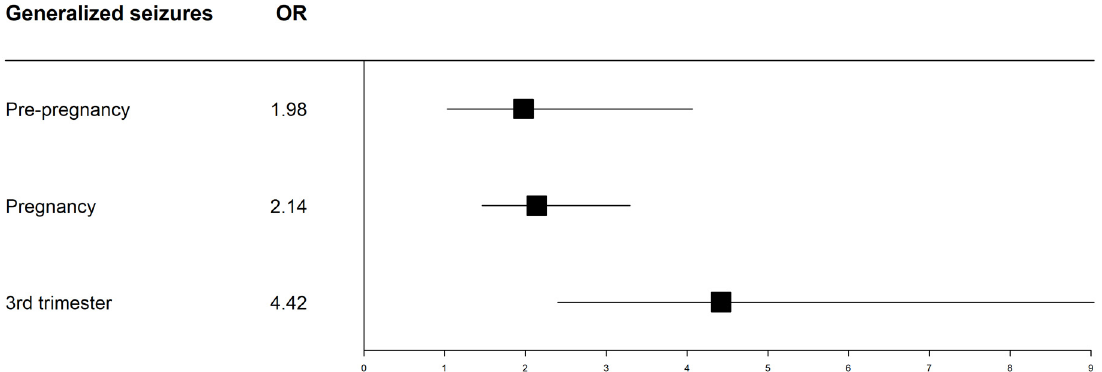
Figure 2. Likelihood of caesarean section according to the occurrence of generalized seizures pre- pregnancy, throughout the entire pregnancy, and in the 3rd trimester. Odds ratios (ORs) for caesarean section are presented as a forest plot with corresponded 95% confidence interval.